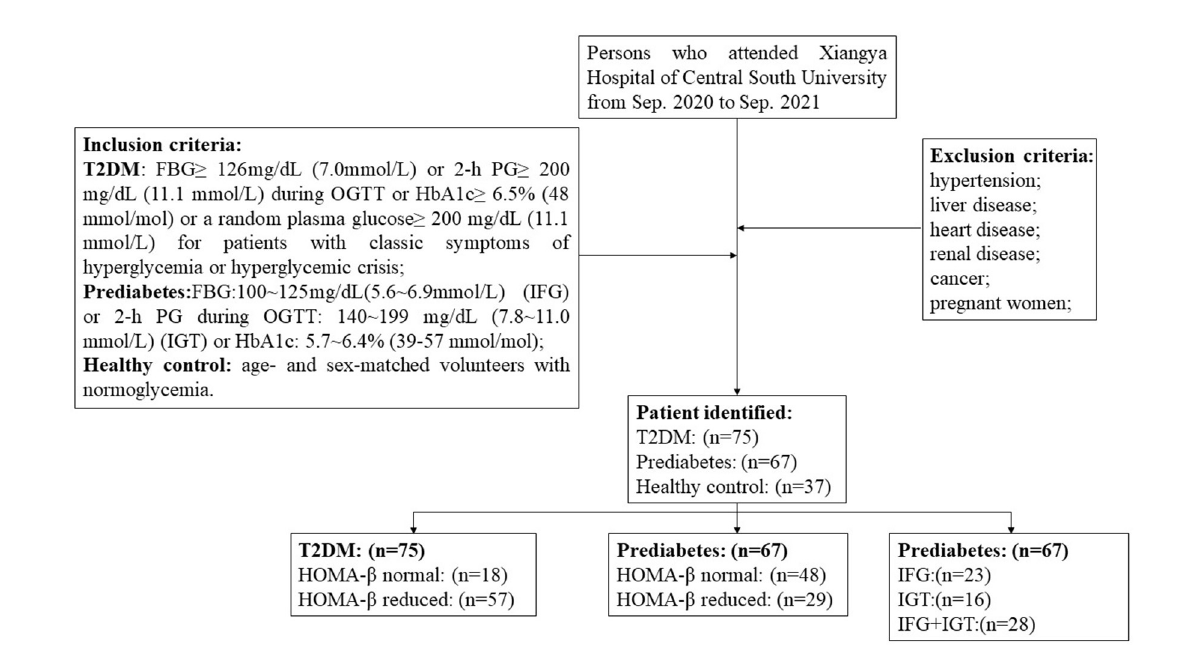
FIGURE1 Flow chart depicting patient